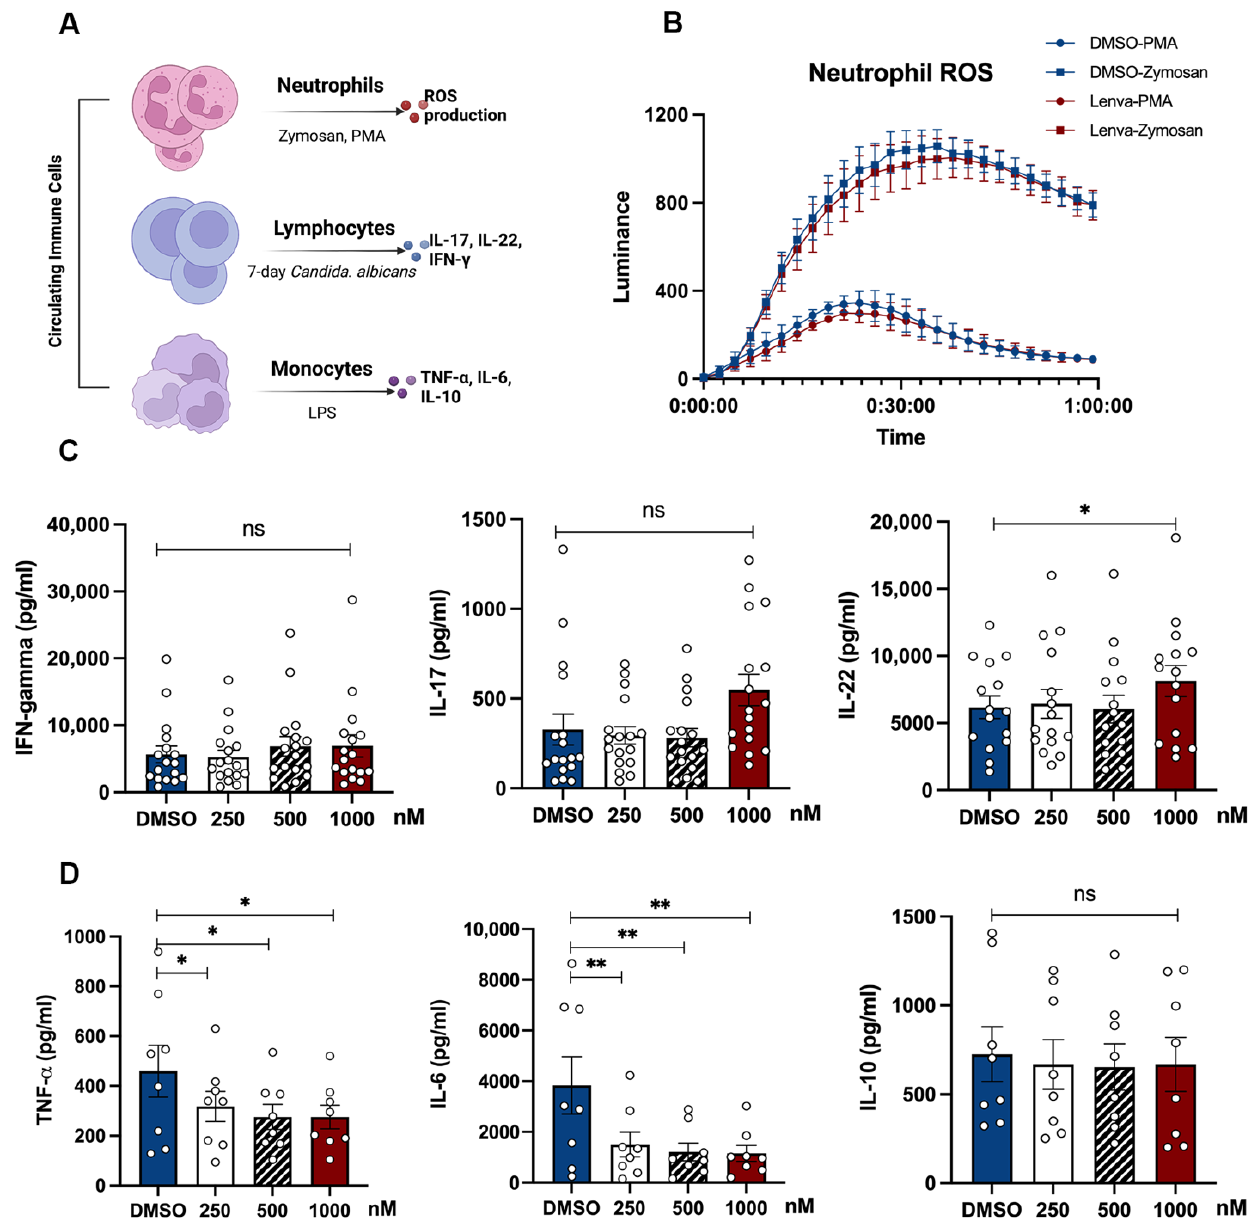
Figure 1. Lenvatinib modulates in vitro monocyte-derived cytokine secretion in dose–response experiments. ( A ) Schematic diagram of the dose–response test. Freshly isolated neutrophils were stimulated with opsonized zymosan or PMA for the measurement of ROS production, after brief exposure to Lenvatinib (1 µ M) for 1 h. PBMCs from healthy donors were incubated with Lenvatinib with indicated concentrations for 24 h, after which cells were stimulated with LPS or Candida albicans. Cytokines levels in supernatants were determined by ELISA. ( B ) ROS production from neutrophils; data represent mean ± SME at each time point, n = 6. ( C ) Lymphocyte-derived cytokines (IFN- γ , IL-17, and IL-22) after 7-day Candida albicans stimulation, n = 15. ( D ) Monocyte-derived cytokines (IL-6, TNF- α , IL-10) after 24 h of LPS stimulation, n = 8. The bar graphs indicate mean ± SME; each dot represents one healthy donor. * p < 0.05, ** p < 0.01 by nonparametric Wilcoxon matched-pair tests; ns, not significant; PMA, phorbol myristate acetate; ROS, reactive oxygen